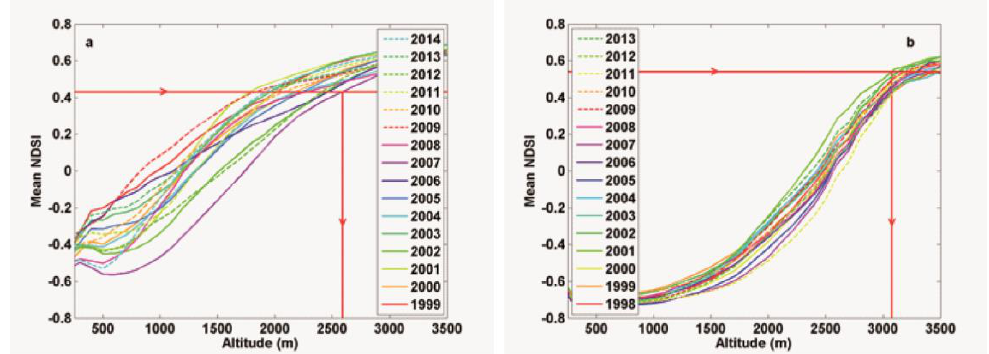
Figure 9. Example of altitudinal distribution of NDSI for each year since 1998. The NDSI was averaged in a square window centred on Griesgletscher, central Swiss Alps. The red horizontal line represents the NDSI value from which the mean regional snow altitude Z (represented by the red vertical line) is inferred for each year. ( a ) Winter NDSI over 1999–2014; ( b ) summer NDSI over 1998–2014. From Drolon et al. [51].